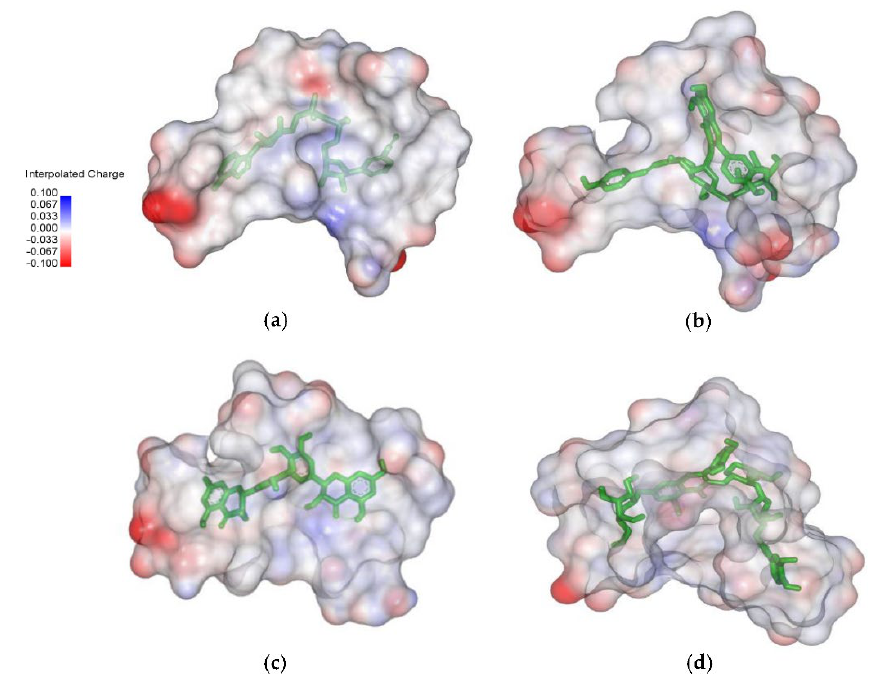
Figure 2. Molecular electrostatic potential maps between ligand and protein target InhA. ( a ) NAD; ( b ) C00013874; ( c ) C00006532; ( d )